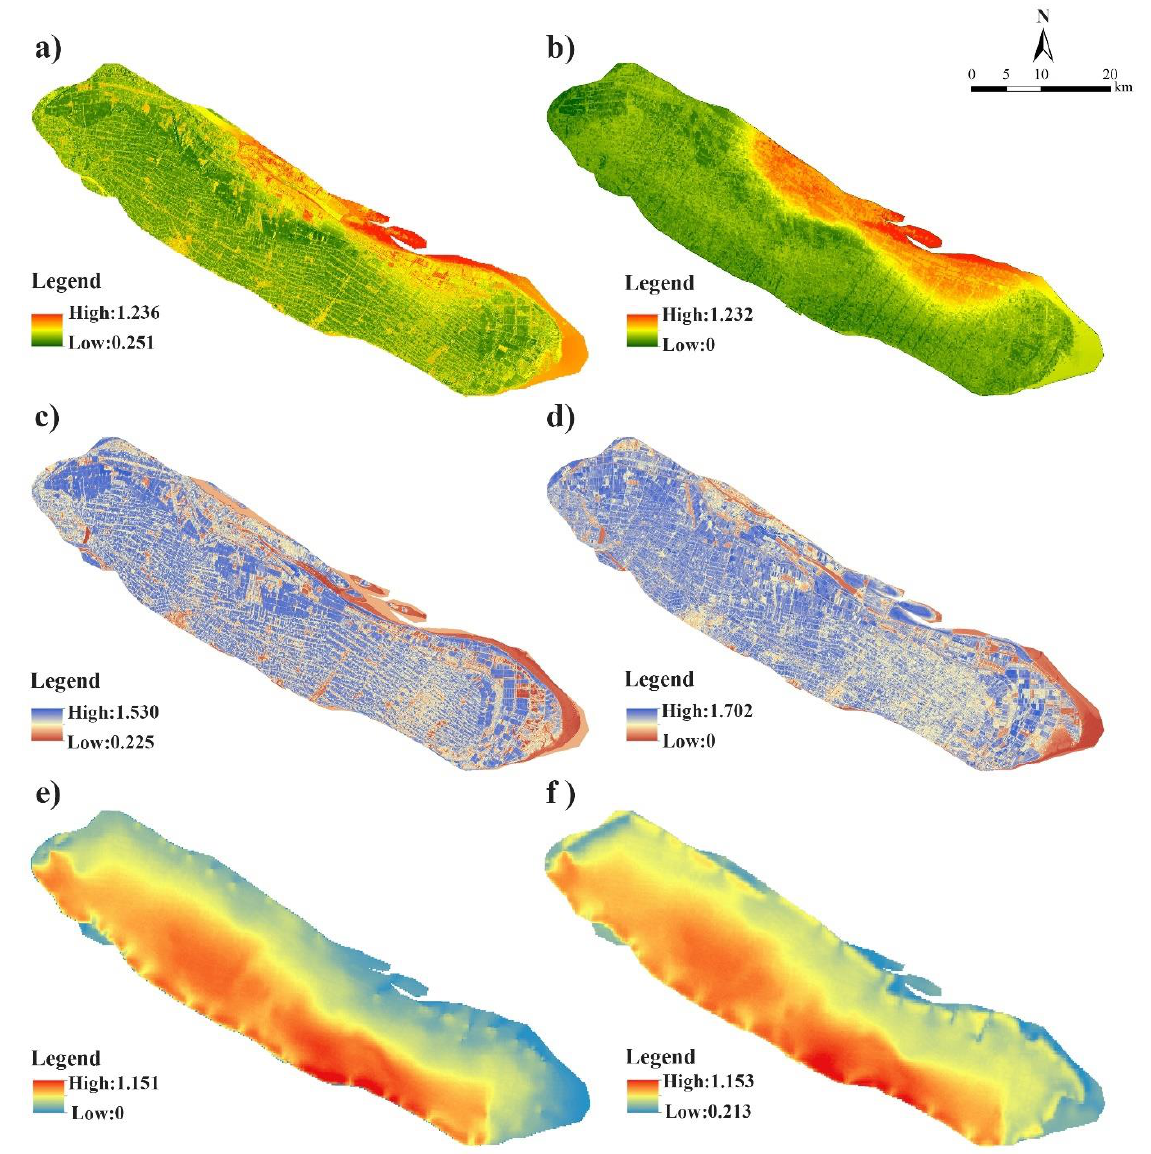
Figure 3. The ecological vulnerability assessment results of the three subsystems of Chongming Island in 2010 and 2015. ( a ) shows the result of pressure subsystem in 2005; ( b ) shows the result of pressure subsystem in 2015; ( c ) shows the result of the state subsystem in 2005; ( d ) shows the result of the state subsystem in 2015; ( e ) shows the result of the response subsystem in 2005; ( f ) shows the result of the response subsystem in 2015.